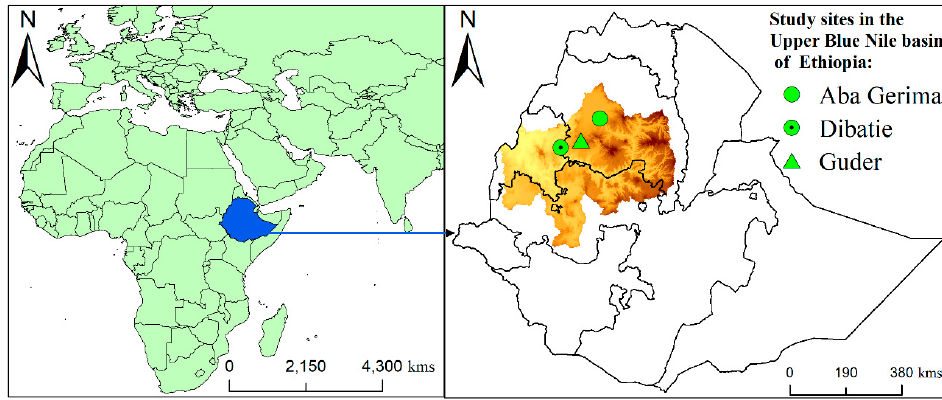
Figure 1. Location of the study sites.